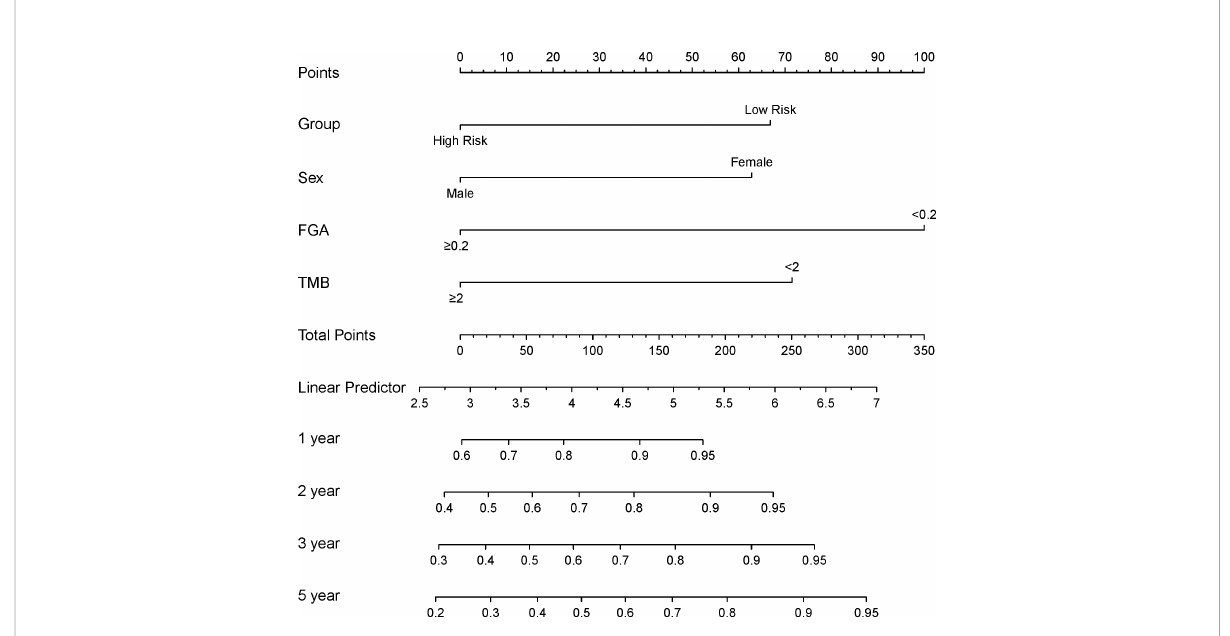
FIGURE 4 Construction of a prognostic nomogram for patients with GISTs. FGA, fraction genome altered; TMB, tumor mutational